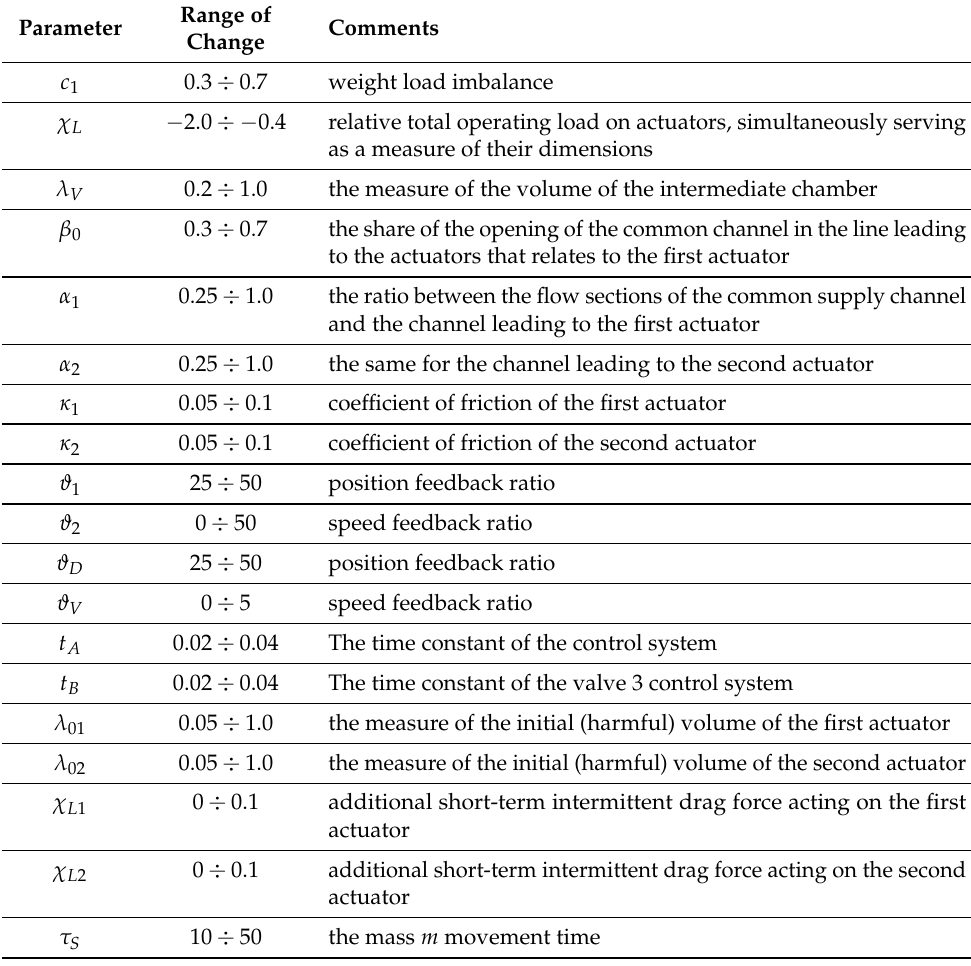
Table 1. The optimized parameters of the system and the ranges of their values.